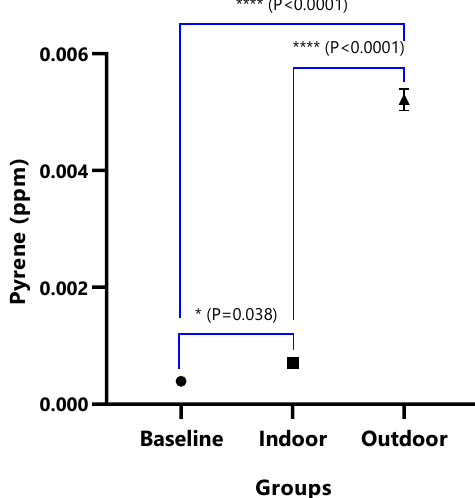
Figure 10. The mean concentrations and test of mean difference for Pyrene.